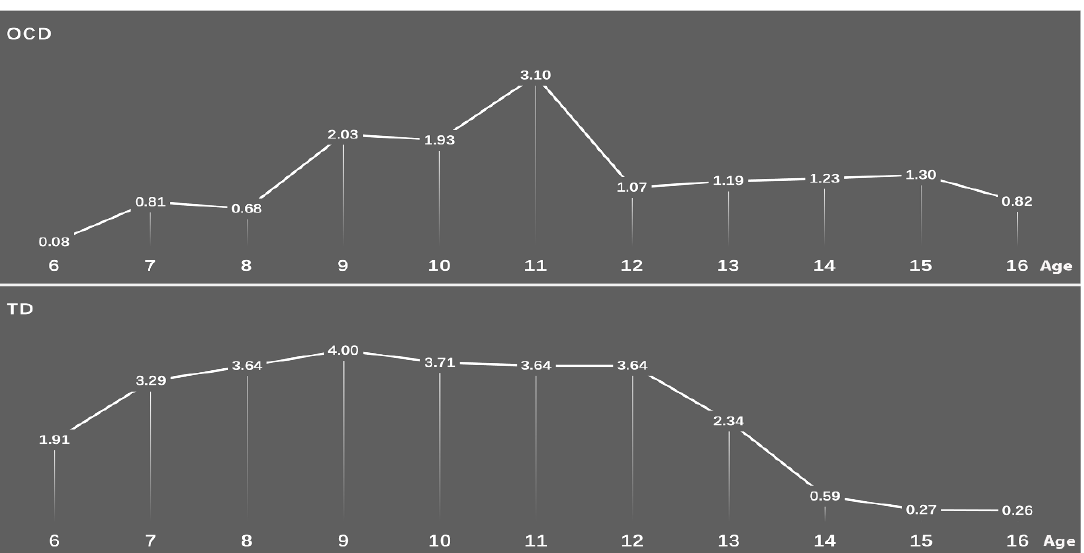
Figure 2. Changes in the prevalence rates of TD and OCD with age (OCD: obsessive-compulsive disorder; TD: tic disorders).